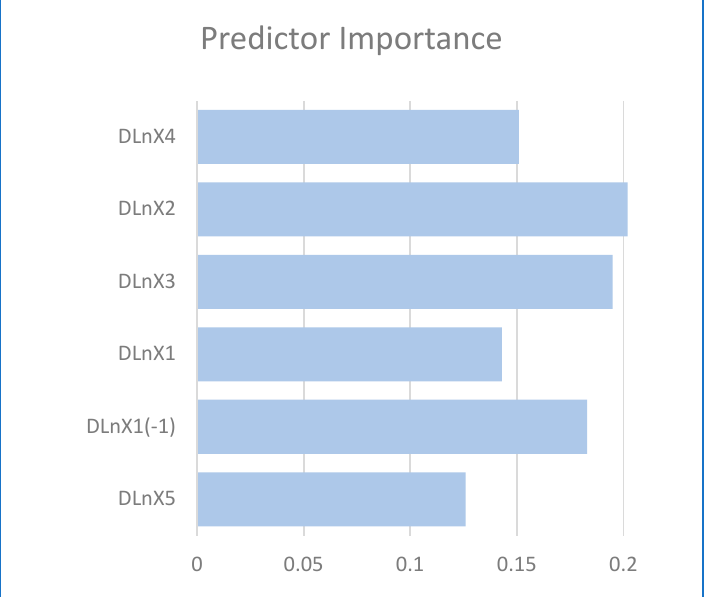
Figure 3. Predictor importance.